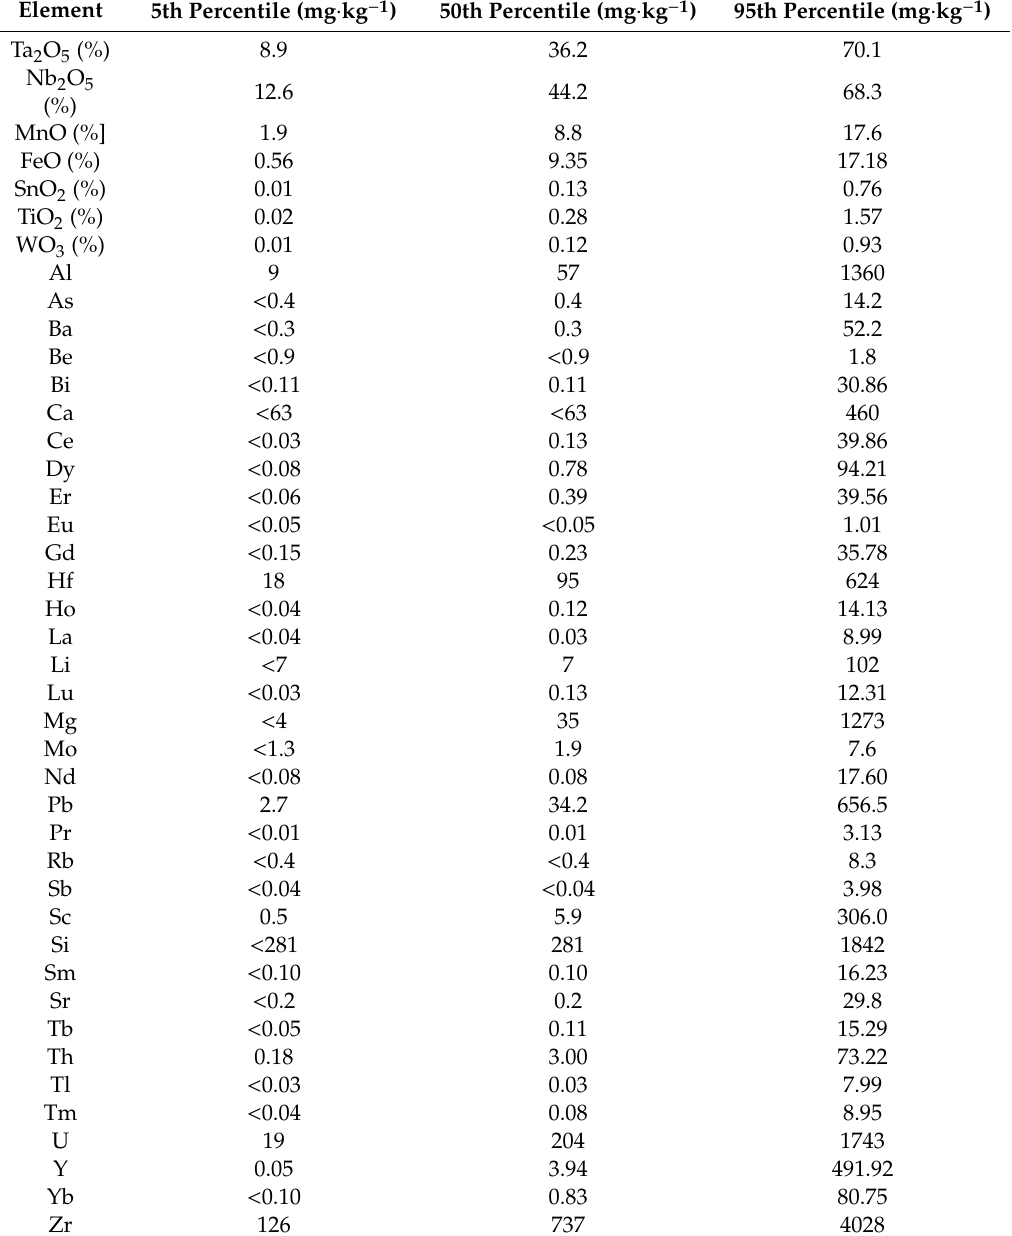
Table 2. Summary statistics of element concentrations in coltan grains. Please note that the concentrations of the main element oxides are given in